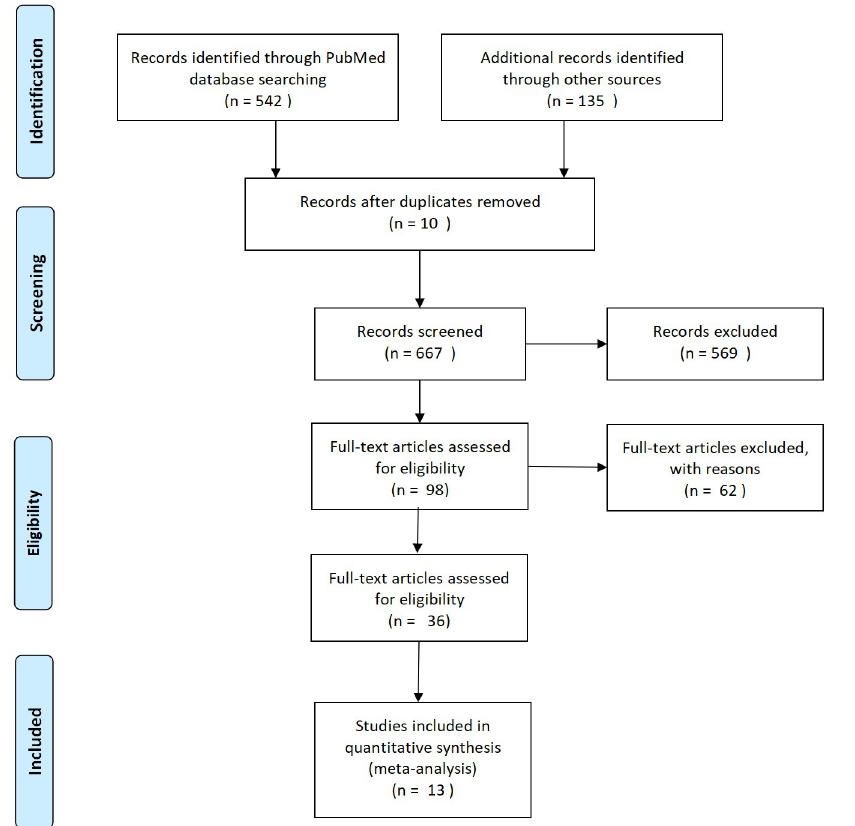
Fig 1. Prisma 1 flow diagram of the searching processes and results.